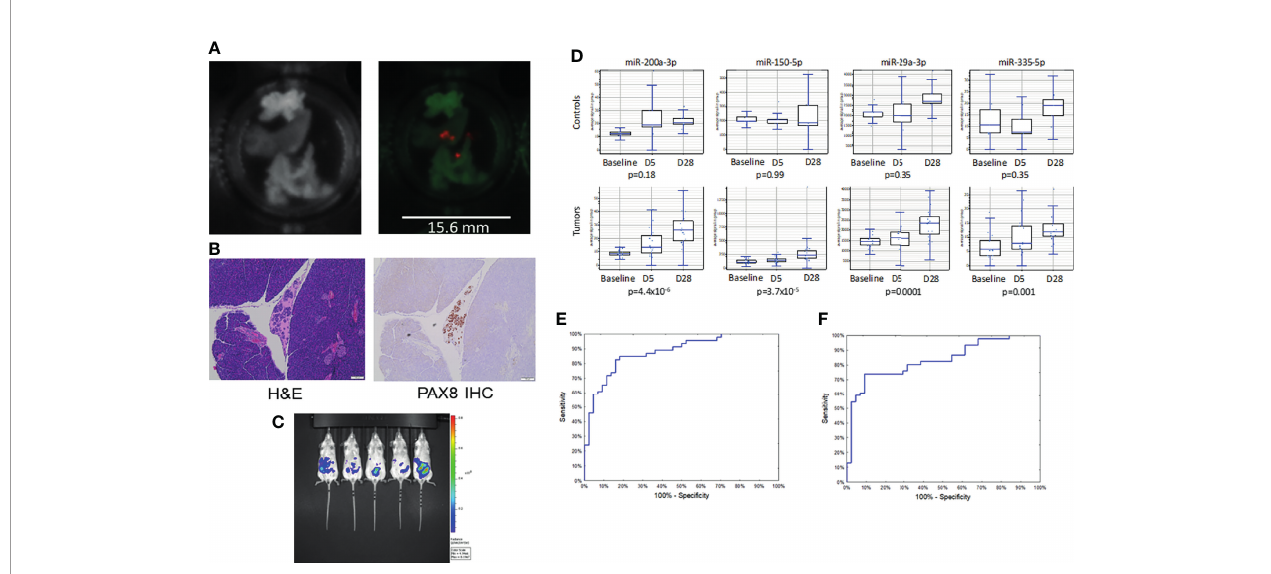
FIGURE 1 | Low volume disease model of ovarian cancer growth. (A) Photograph (l) and bioluminescent images (r) of explanted organs showing sub-millimeter tumor growth at 1 week post-implantation. (B) Micrographs of miliary lesions as seen by hematoxylin and eosin (l) and immunohistochemical staining for the serous carcinoma marker PAX8 (r). (C) Bioluminescent images of mice taken 28 days post-injection with 500,000 tumor cells. (D) Serial miRNA levels among control (n = 5) vs. tumor bearing (n = 15) mice. p-values for trend from baseline to 28 days. (E) Receiver operating characteristic curve for the neural network using the